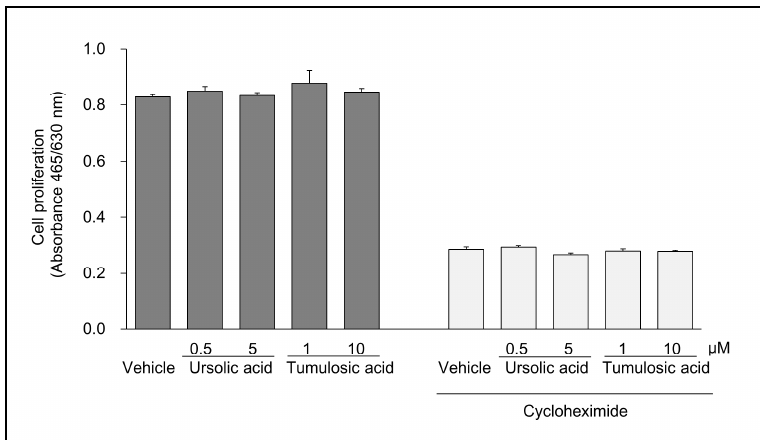
Figure 4. No cytotoxic effect of triterpenoids on cell proliferation. NHEKs were cultured with ursolic acid (0.5 μ M and 5 μ M) or tumulosic acid (1 μ M and 10 μ M) or vehicle in the presence or absence of 10 μ M cycloheximide. After 24 h culture, cell proliferation activities were measured using an XTT-based cell viability assay kit. Optical density at 465 nm was measured by subtracting the reference absorbance at 630 nm. Data are presented as mean ± SEM of triplicate tests.